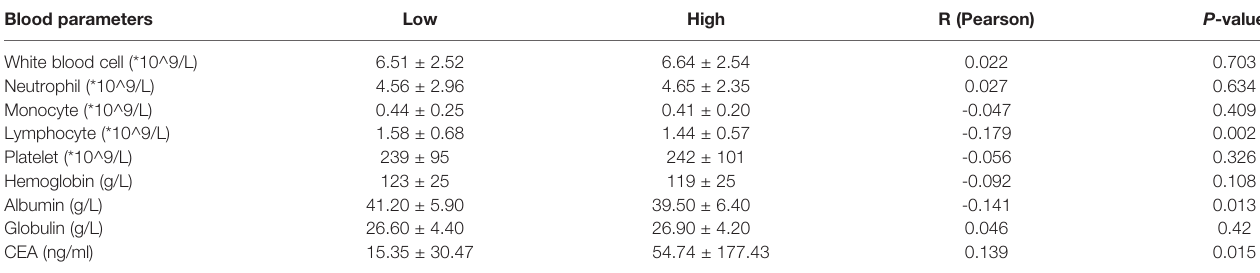
TABLE 2 | Correlation between ARHGAP4 expression and blood parameters. Blood